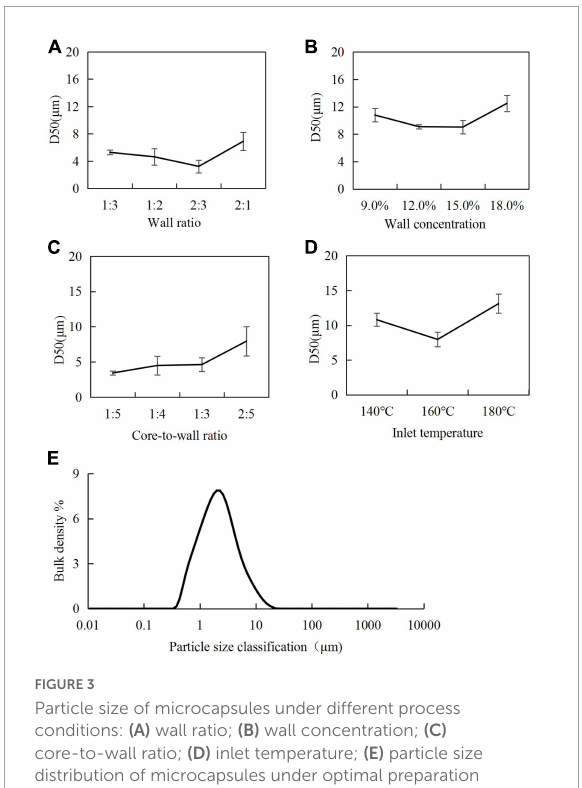
FIGURE3 Particle size of microcapsules under different process conditions: (A) wall ratio; (B) wall concentration; (C) core-to-wall ratio; (D) inlet temperature; (E) particle size distribution of microcapsules under optimal preparation